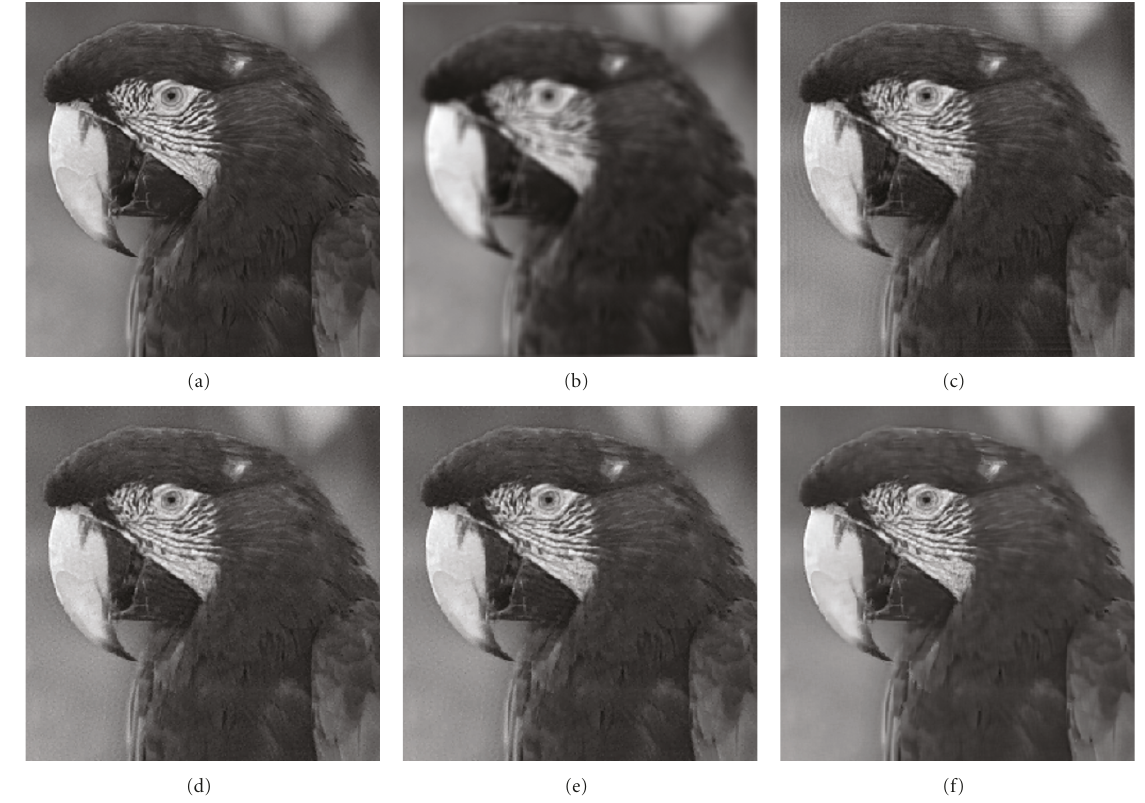
Figure 4: (a) Original “Parrot” image. (b) Degraded “Parrot” image (SNR = 7 . 98) with 7 × 7 uniform blur and additive white Gaussian noise (local variance = 0.3740). (c) Optimal Wiener filter restoration. (d) TV prior Bayesian restoration. (e) Nonquadratic Huber prior Bayesian restoration. (f) The proposed SA prior Bayesian restoration.